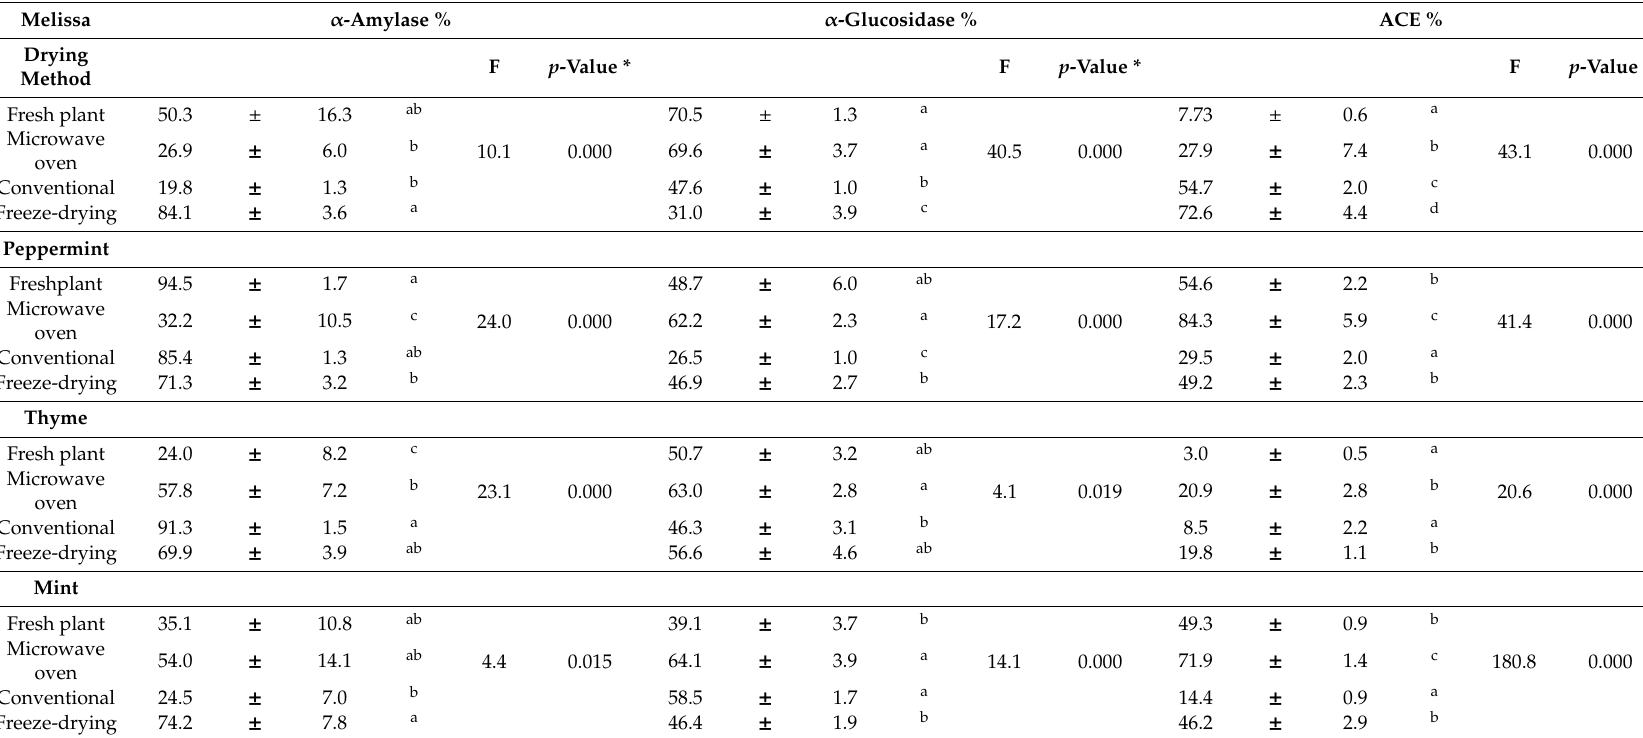
Table 3. Biological activity of secondary metabolites in methanol extracts in melissa, peppermint, thyme, and mint. Melissa α -Amylase % α -Glucosidase